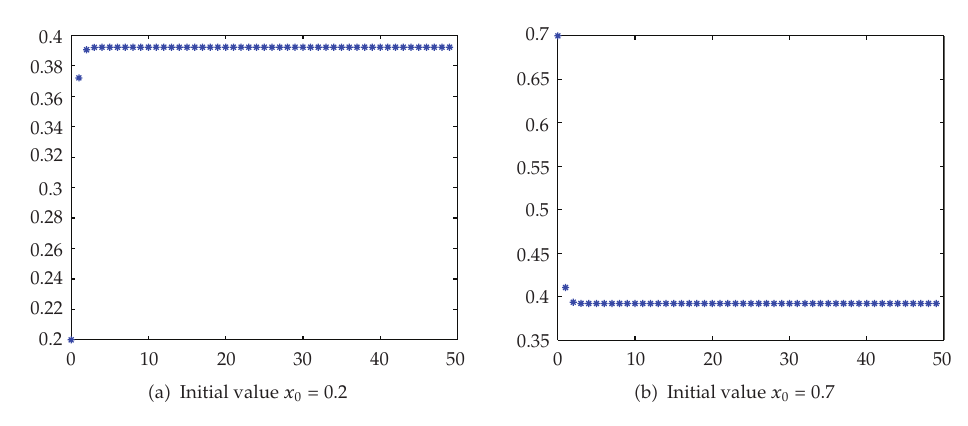
Figure 1: r (cid:5) 1, q (cid:5) 2; x ∗ (cid:5)